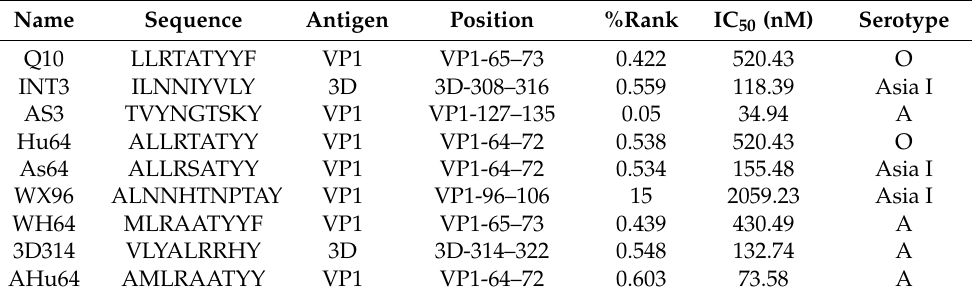
Table 1. The designed peptides derived from three serotypes of